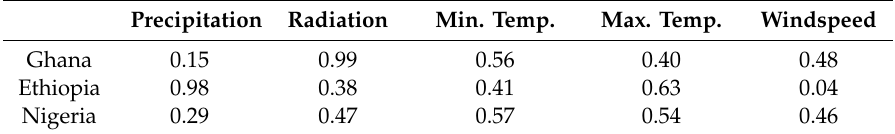
Table 5. Mielke index for five weather variables (Precipitation, Radiation, Minimum Temperature, Maximum Temperature, and Windspeed) for Approach 1 and 2 in study areas in Ghana, Ethiopia, and Nigeria. Precipitation Radiation Min. Temp. Max. Temp. Windspeed Ghana 0.15 0.99 0.56 0.40 0.48 Ethiopia 0.98 0.38 0.41 0.63 Nigeria 0.29 0.47